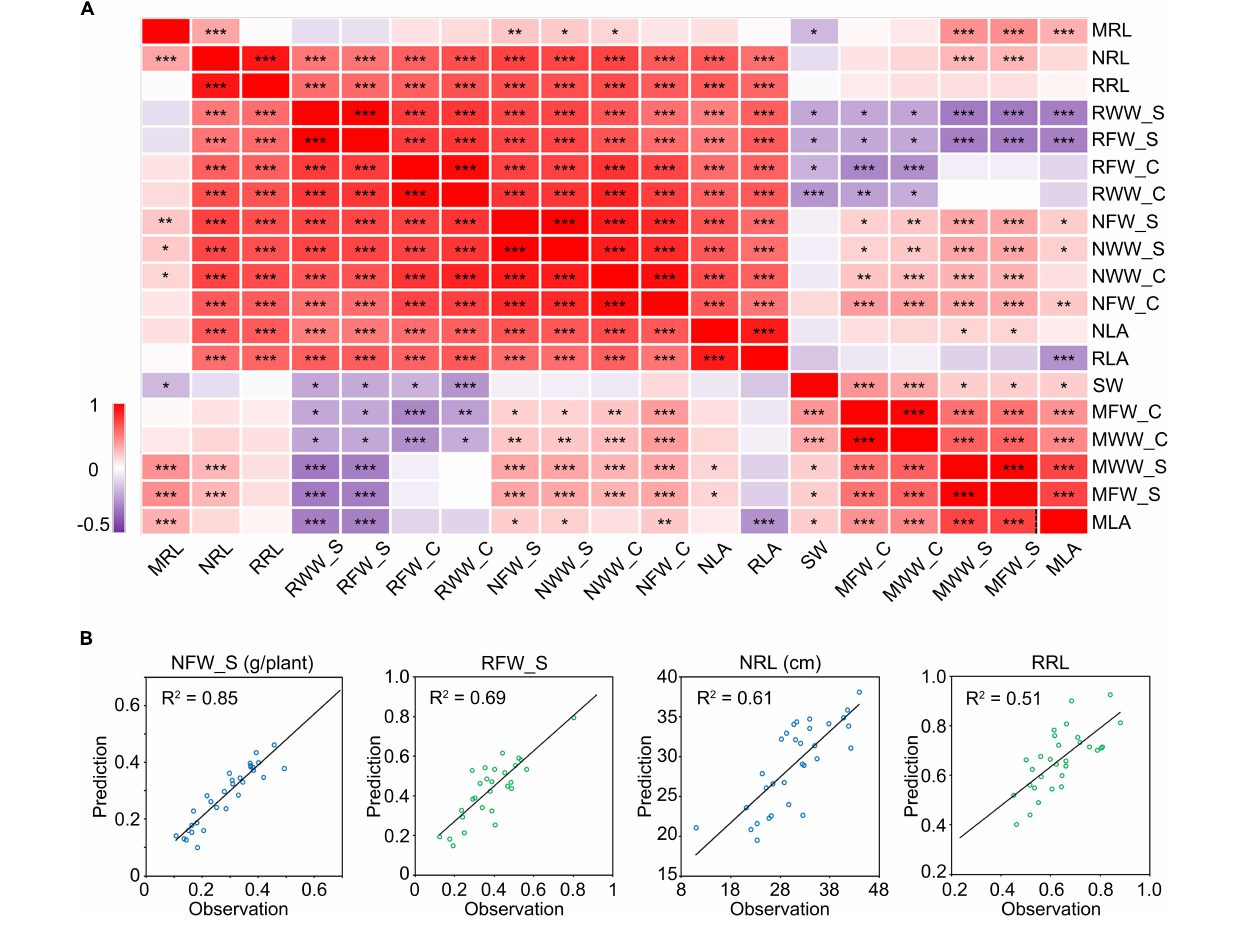
FIGURE 6 | Correlation analysis between salt stress-related traits. (A) Correlation matrix between salt stress-related traits. The numbers in the squares indicate the Pearson correlation coefficients. Data were collected from 10 seedlings of 146 different cultivars grown for 10 days under mock or 175 mM NaCl treatment. * P < 0.05; ** P < 0.01; *** P < 0.001. (B) Regression curve between the predicted value and observed value. The prediction was performed in a new group including 32 cultivars. The first letter “M” in the index name means “mock treatment,” “N” means “NaCl treatment” and “R” means “relative index” (NaCl